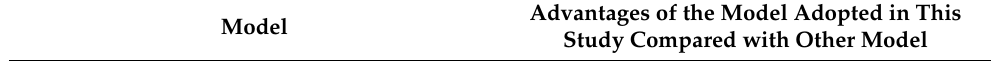
Table 1. Comparison of the model used in this study with other models. Advantages of the Model Adopted in Model